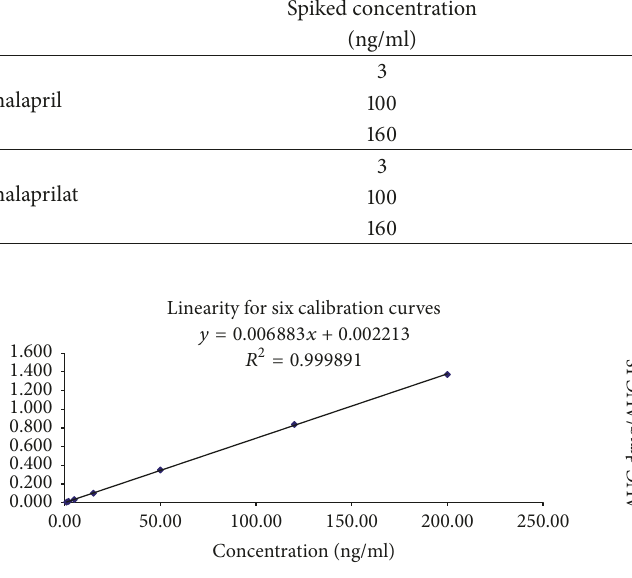
Figure 4: Calibration curve of peak area versus concentration (ng/ml) for